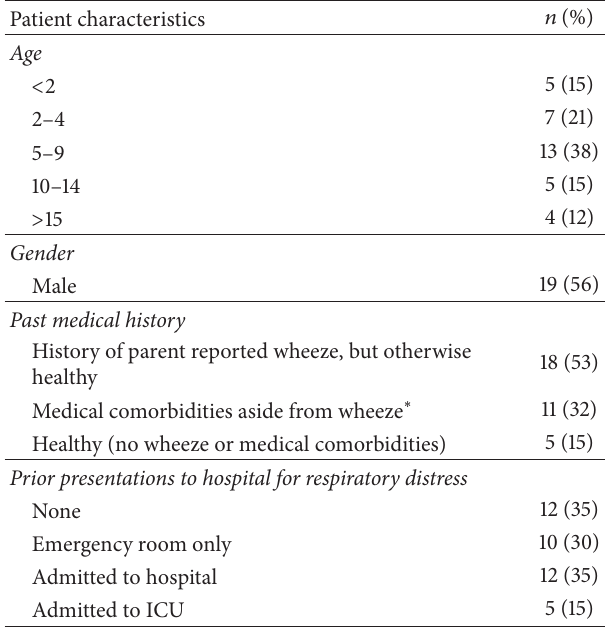
Table 1: Characteristics of hospitalized children testing positive for EV-D68 ( 𝑛 = 34